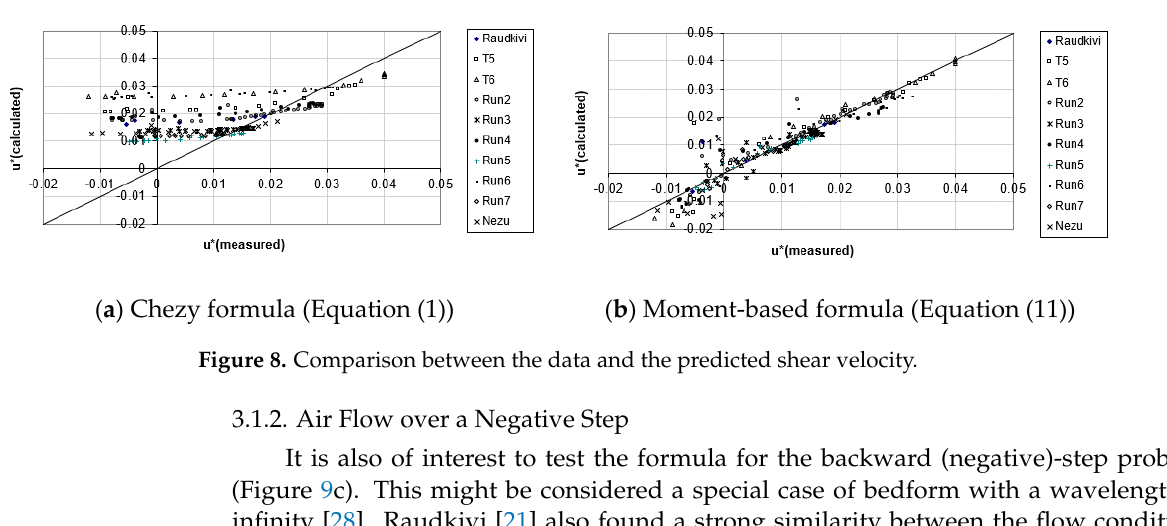
Figure 7. Flow over a fixed bedform (Experiment T5): ( a ) spatial variation of bed shear velocity, ( b ) integral moment velocity, ( c ) depth-averaged velocity, and ( d ) geometry of the bedform.